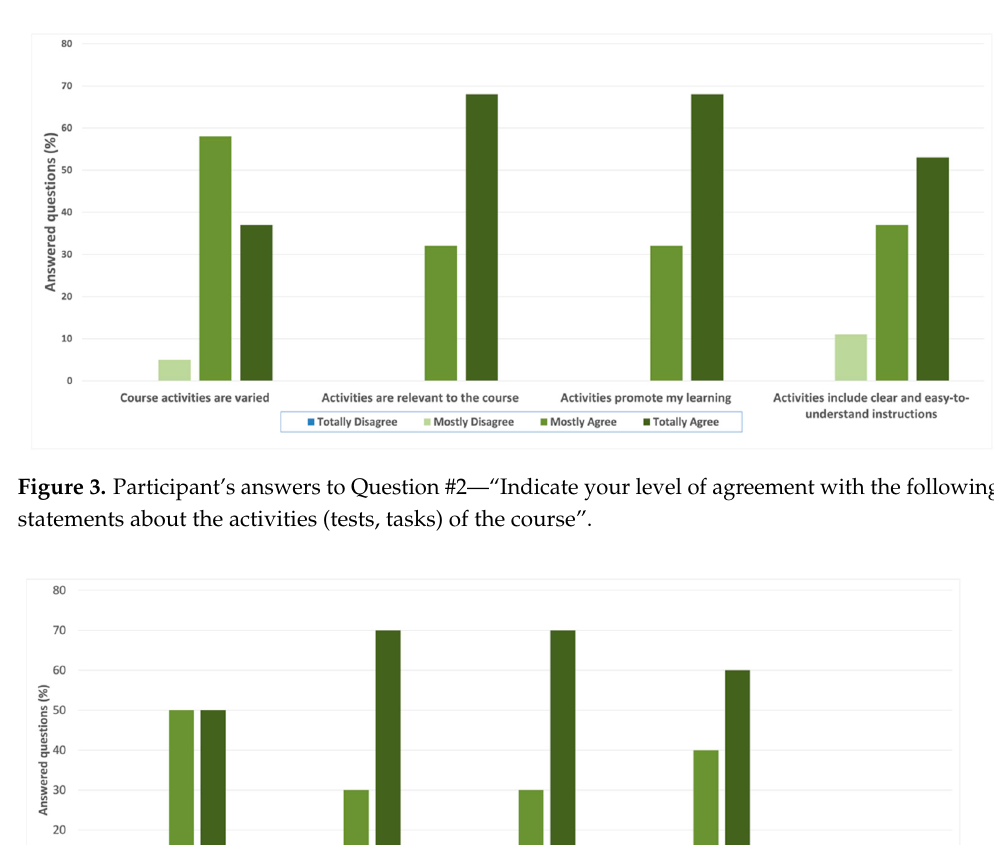
Figure 3. Participant’s answers to Question #2—“Indicate your level of agreement with the follow ‐ ing statements about the activities (tests, tasks) of the course.”